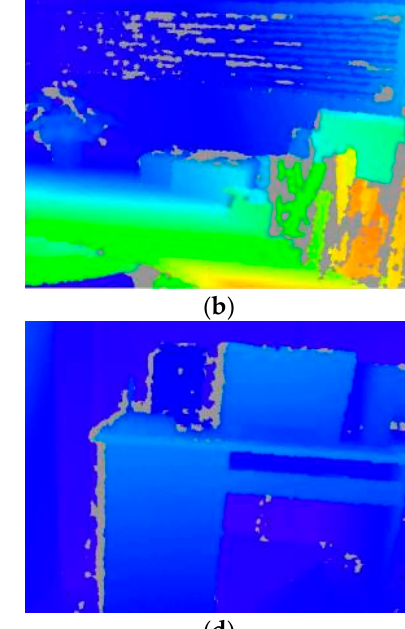
Table 1. The comparison about feature points extracted by each algorithm and their time consumption.